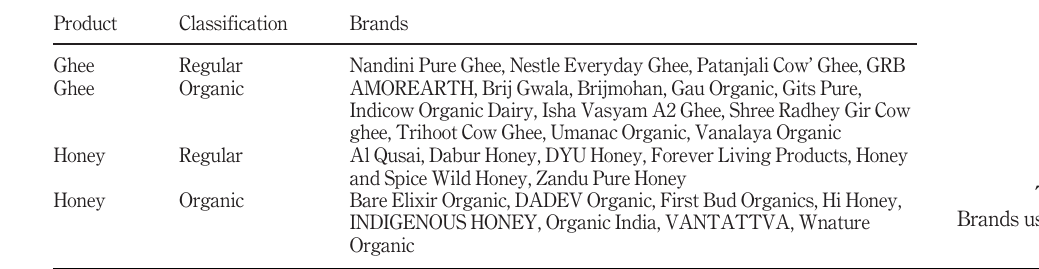
Table 2. Brands used in the